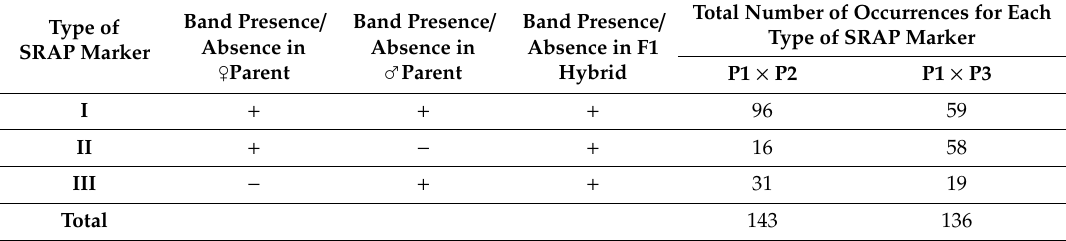
parental crosses (P1 × P2 and P1 ×